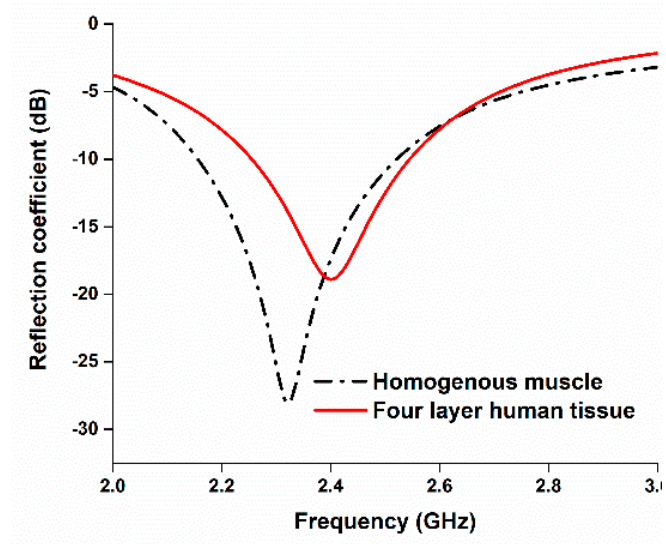
Figure 15. Reflection coefficients of the antenna with homogeneous muscle phantom and four-layer human tissue.